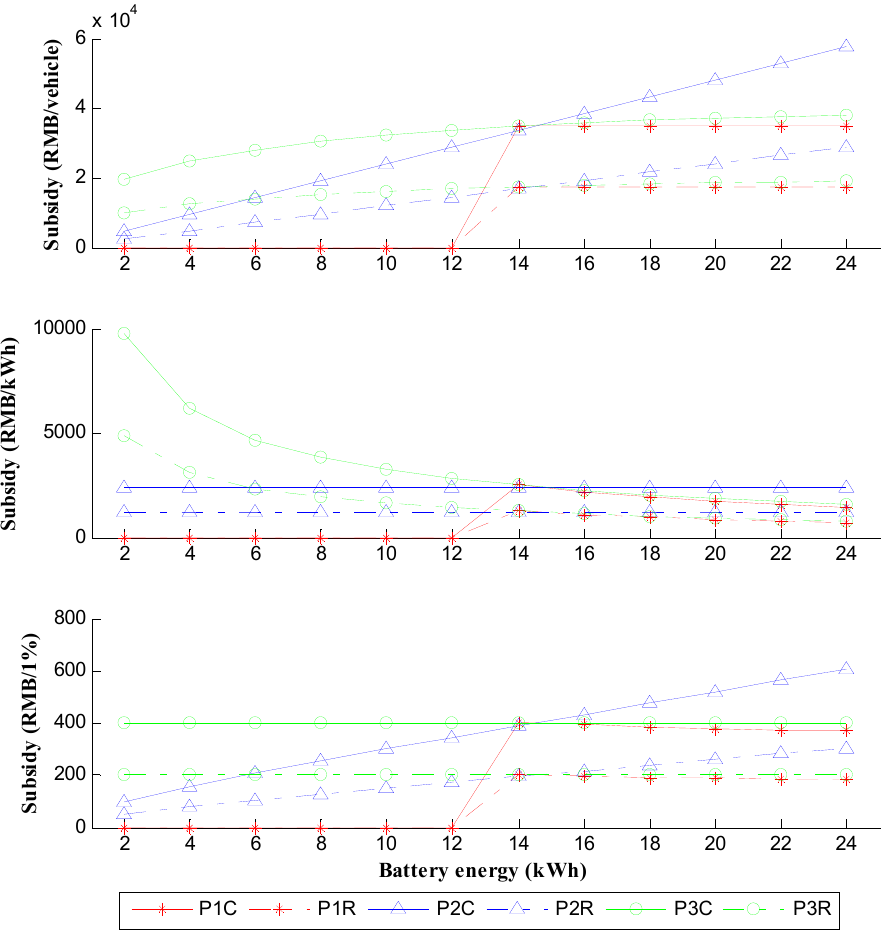
Figure 10. Policy illustration with three different